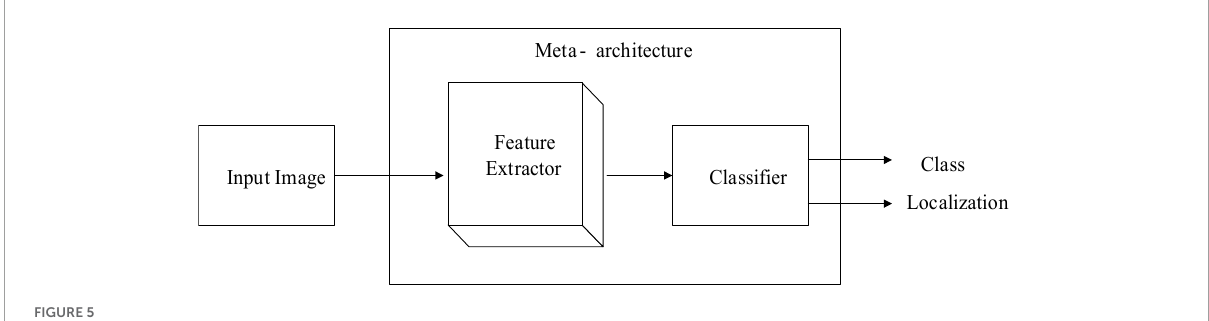
FIGURE5 Feature’s extractor and classifier in architecture of meta